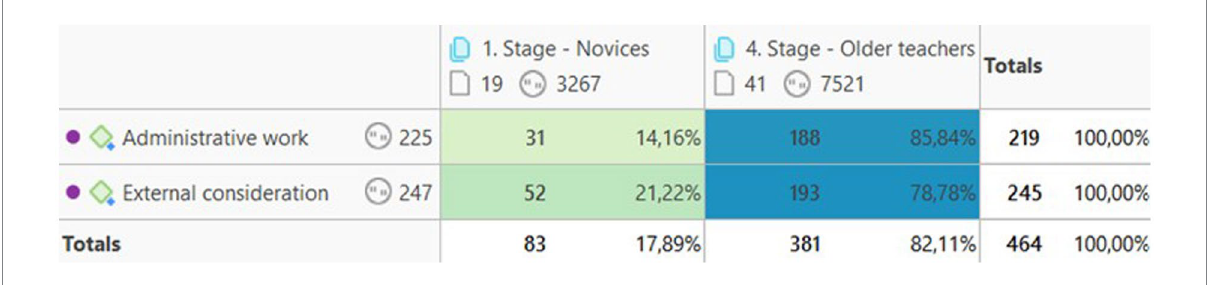
FIGURE 3 Relationship between codes and groups of